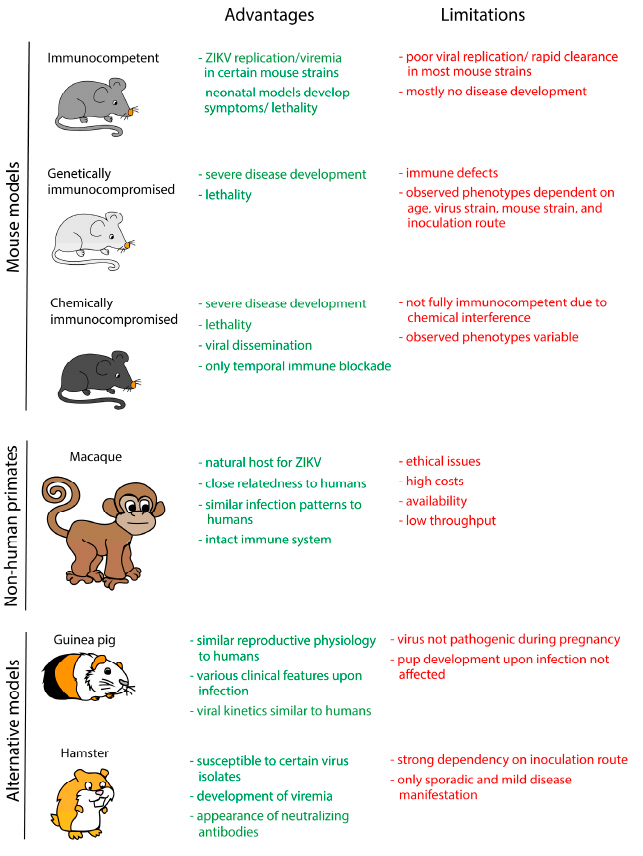
Figure 3. Overview of the currently available in vivo models for the study of ZIKV pathogenesis and for possible antiviral approaches. The text highlighted in green and red indicates advantages and limitations, respectively.